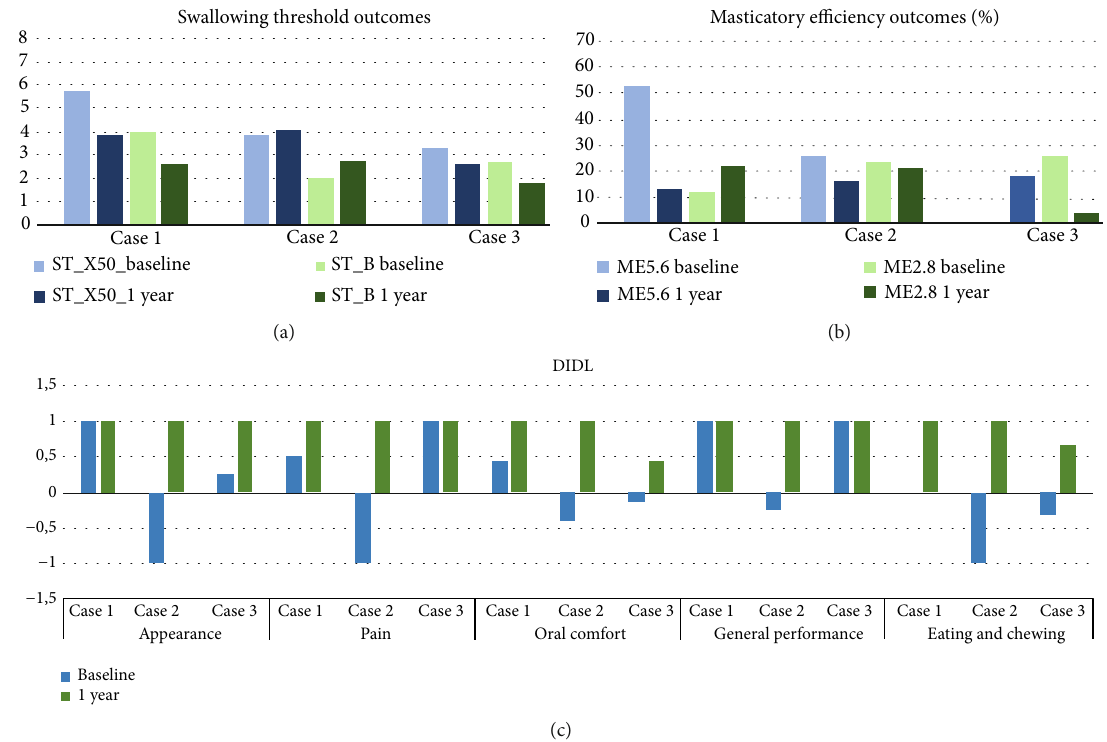
Figure 7: (a) Swallowing threshold outcomes (in mm). (b) Masticatory e ffi ciency outcomes (in %). (c) Oral health-related quality of life outcomes (DIDL questionnaire scores; higher is better). Table 2: Marginal bone loss by case, number of implants (I), and type of loading. Abbreviations: IL: immediate loading; CL: conventional loading; HL: hybrid